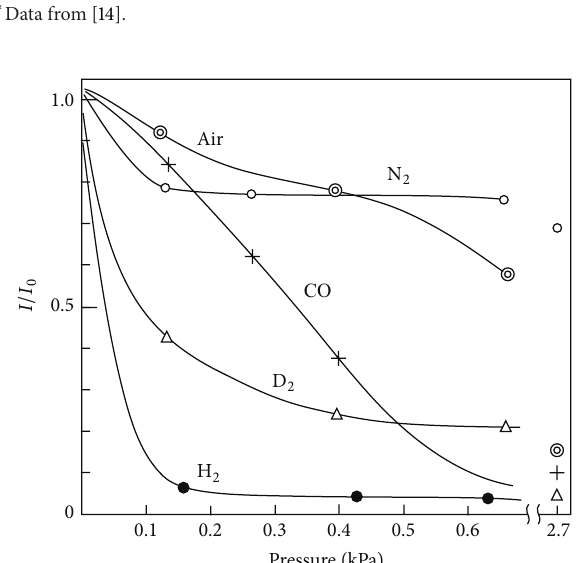
indicated that upon adding air, CO, N 2 , H 2, or D 2 at pressures of up to 2.7 kPa and He at a pressure of up to 400 kPa into the Kr-Xe mixture, no luminescence appeared at 𝜆 ∼ 660